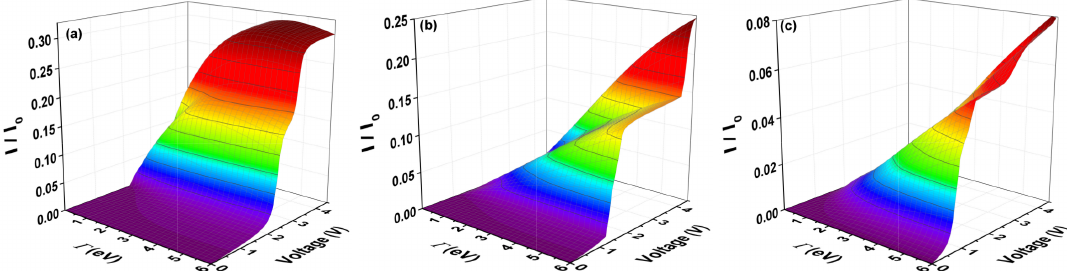
Figure 7. (color online) I − V characteristic I / I o as a function of bias voltage and the molecule–electrode coupling ( Γ ) for the molecular system with ( a ) one ring; ( b ) two rings; and ( c ) three rings for E c = − 5.54 eV, E s = 0.98 eV, t d = t δ = t c = − 2.40 eV, and t τ = t s = − 0.83 eV.